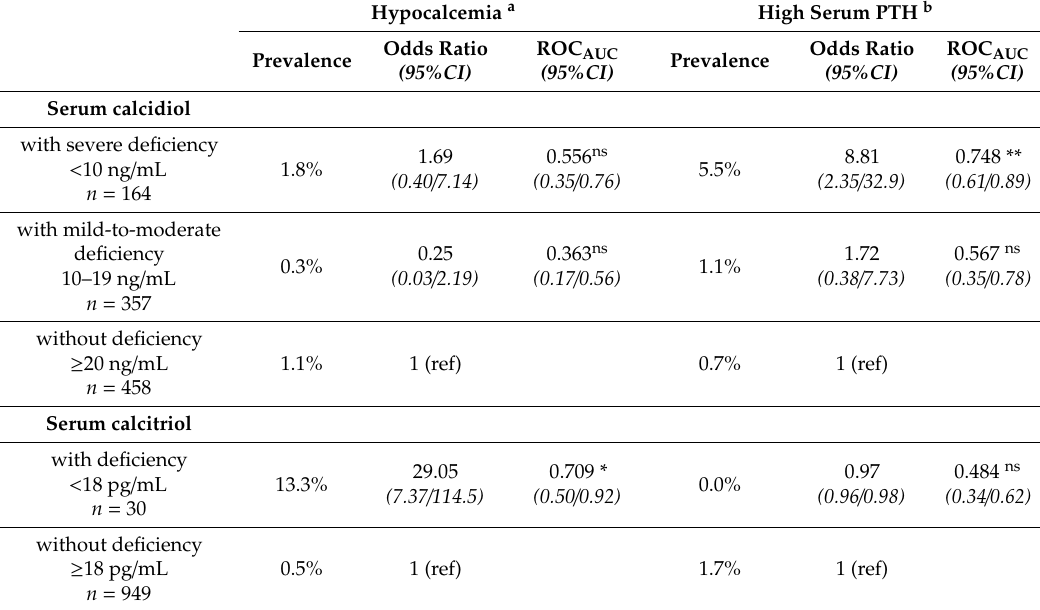
Figure 1. Frequency distribution and skewness (95% CI) of serum calcidiol (left panel, recalibrated data) and of serum calcitriol (right panel). The number of persons per stratum of concentration is shown within parentheses on the top of each bar. Table 1. Association of deficiency of calcidiol (data of the recalibrated chemiluminescent assay) with hypocalcemia and high serum parathyroid hormone (PTH): Prevalence, odds ratio, and area under the curve of receiver operating characteristic curve (ROC AUC ) with